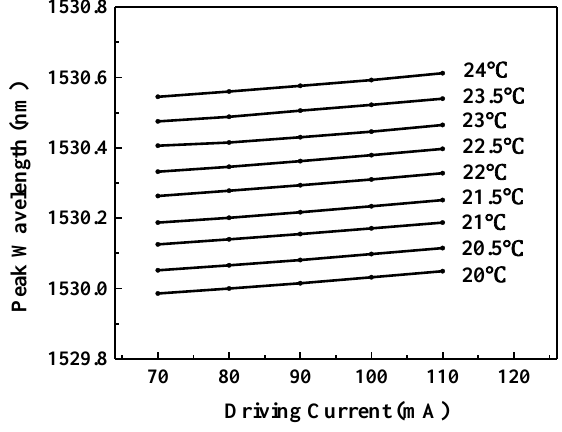
Figure 3. Tuning characteristics of the 1.53 µm DFB diode laser.